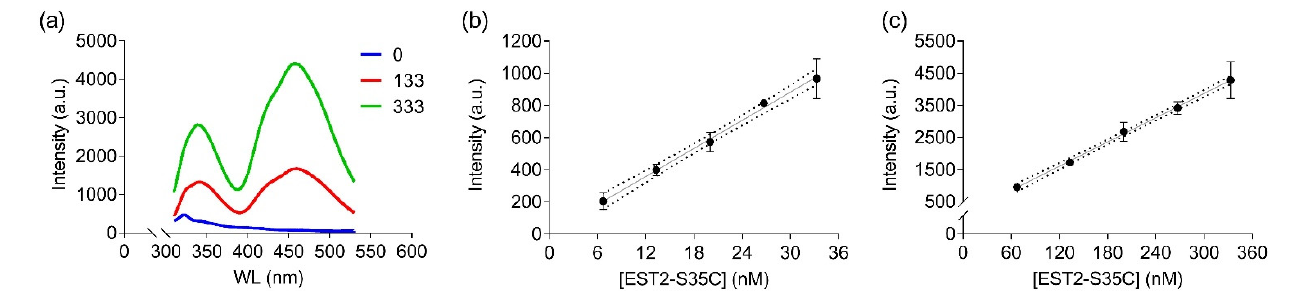
Figure 2. FRET measurements of labelled EST2-S35C after excitation at 290 nm: ( a ) illustrative FRET fluorescence spectra for 0, 133 and 333 nM of EST2-S35C; ( b , c ) fluorescence intensity (arbitrary units, mean ± SD, n = 3) at the maximum of emission (457–460 nm) for increasing EST2-S35C concentrations (low and high ranges, respectively).